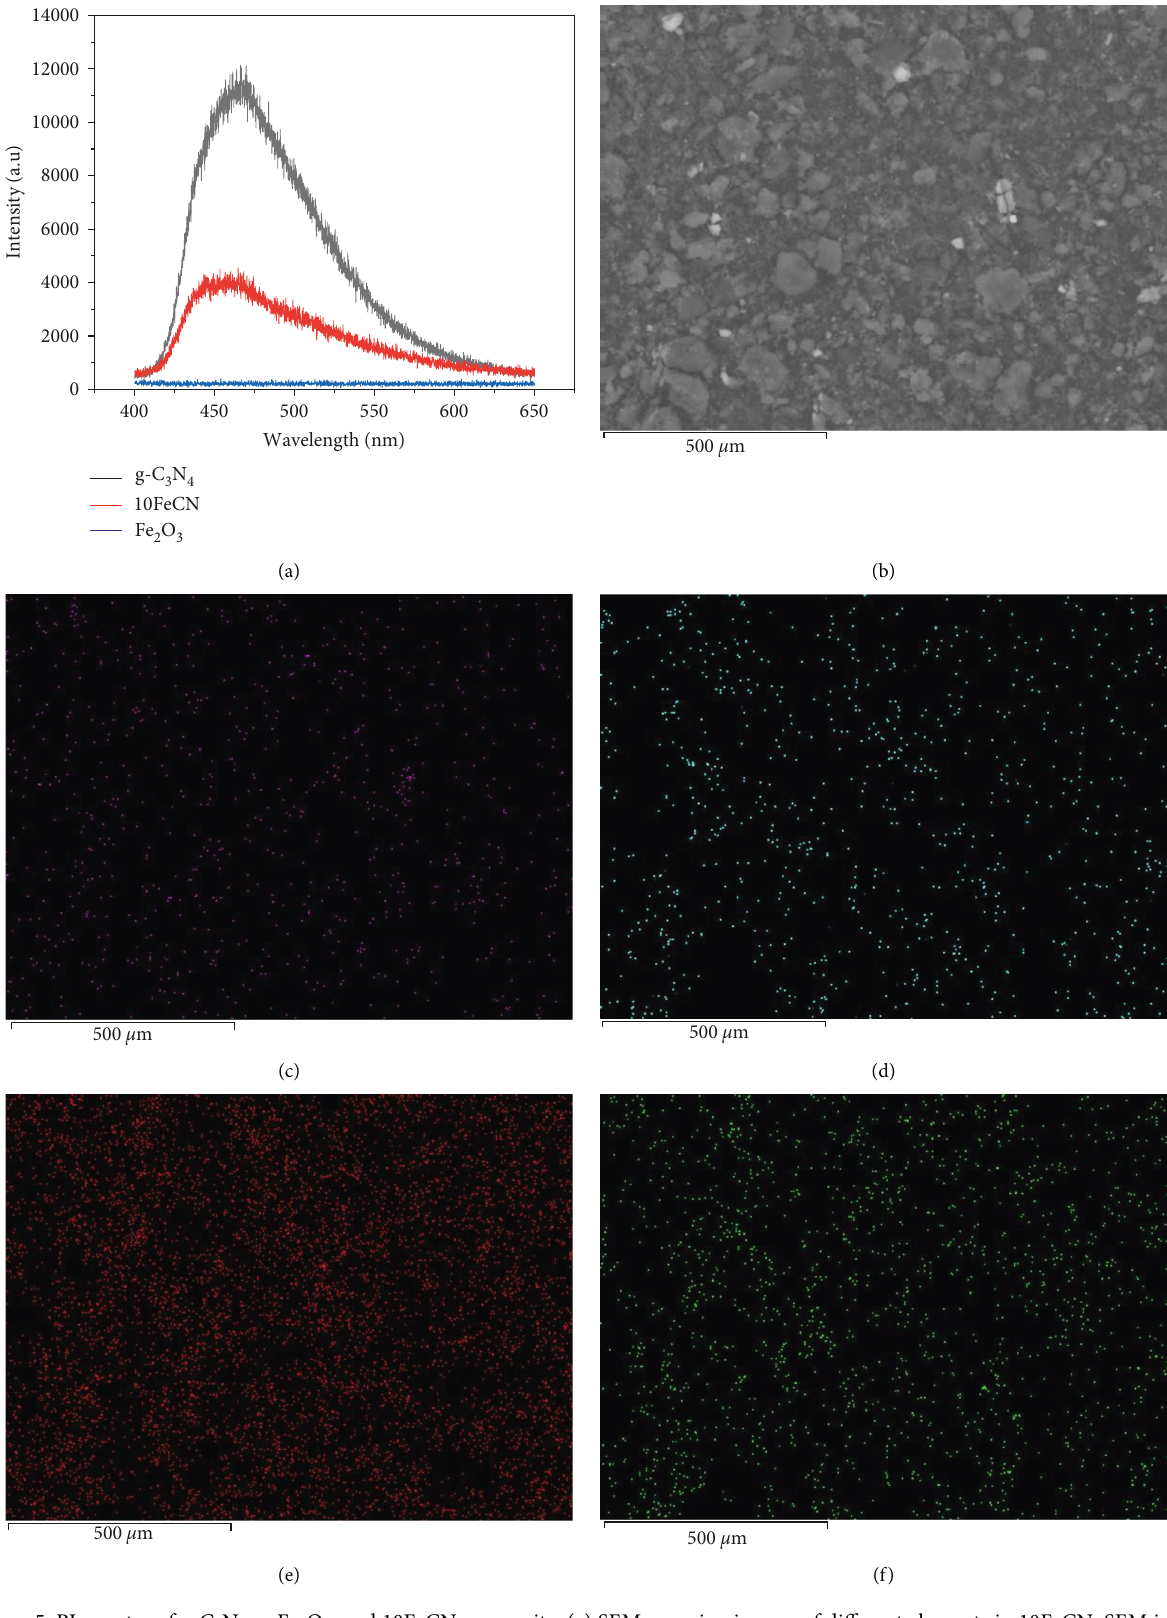
Figure 5: PL spectra of g-C c -Fe 3 N 4 , 2 O 3 , and 10FeCN composite. (a) SEM mapping images of different elements in 10FeCN: SEM image (b), Fe distribution (c), O distribution (d), C distribution (e), and N distribution